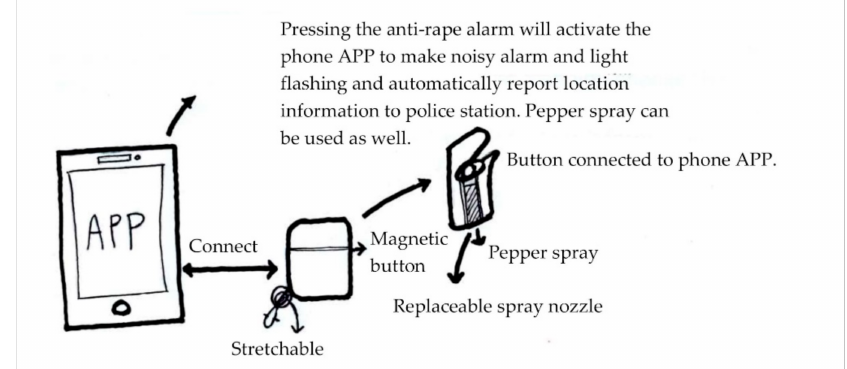
Figure 6. One of the solutions generated from the student group for a female self-defense